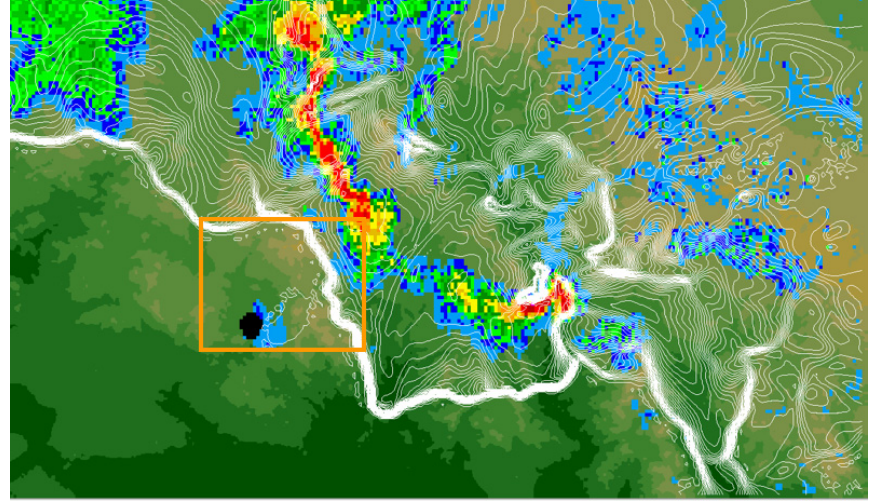
Figure 7. Same as for Figure 5 but valid for 1500 LST.